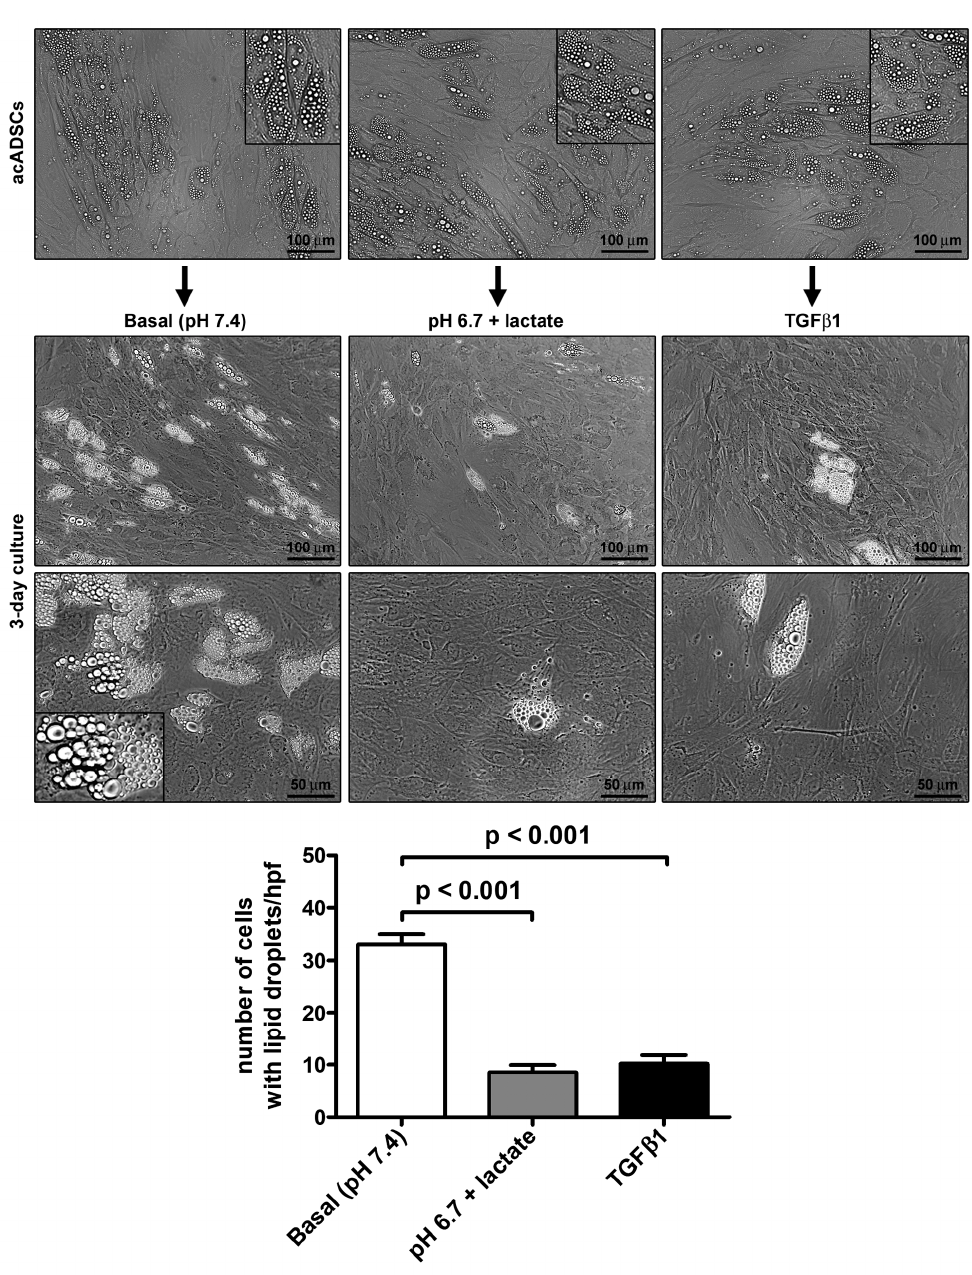
Figure 1. Representative phase-contrast photomicrographs of adipocyte-committed adipose-derived stem cells (acADSCs) cultured under basal conditions (pH 7.4), lactic acidosis (pH 6.7 + lactate), or in the presence of 10 ng/mL TGF β 1 for 3 days. Insets are higher magnification views of the respective panels, displaying prominent intracytoplasmic lipid droplets. Scale bar: 100 µm (upper and middle panels), 50 µm (lower panels). Bars represent the mean ± SEM of the number of cells with intracytoplasmic lipid droplets/high-power field (hpf). Values of p were determined by Tukey’s test.